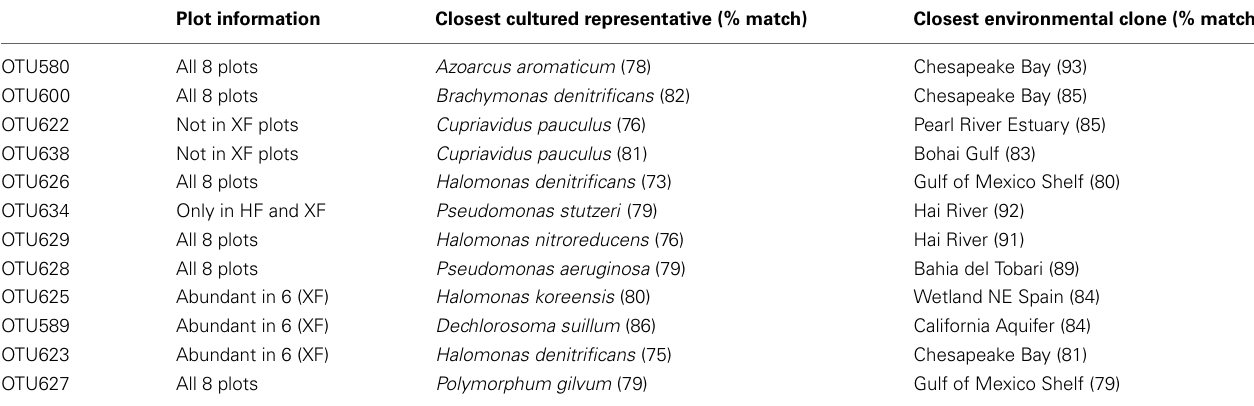
Table 3 | Closest matches of OTUs present more than 1000 times (in descending order from the most abundant) to both a cultured representative and to an environmental